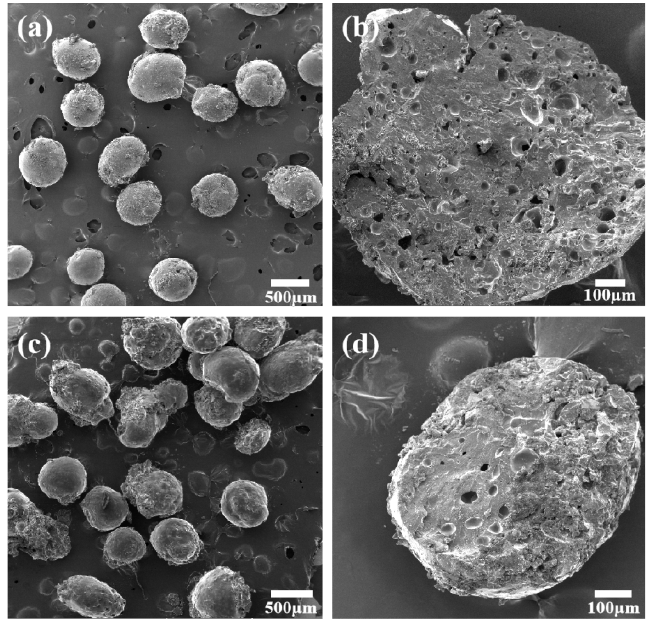
Figure 1. SEM images of HPC/CS@5-Fu (3:2) ( a ) surface and ( b ) cross section, GO/HPC/CS@5-Fu (0.1:3:2) ( c ) surface and ( d ) cross section.